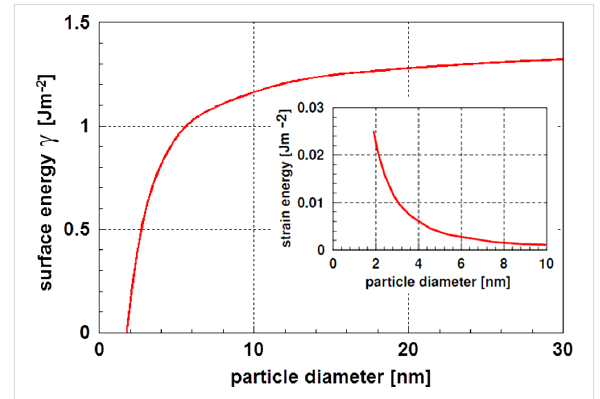
Figure 5: Surface energy for gold nanoparticles as function of the par- ticle diameter according to Gang et al. [26]. The insert shows the